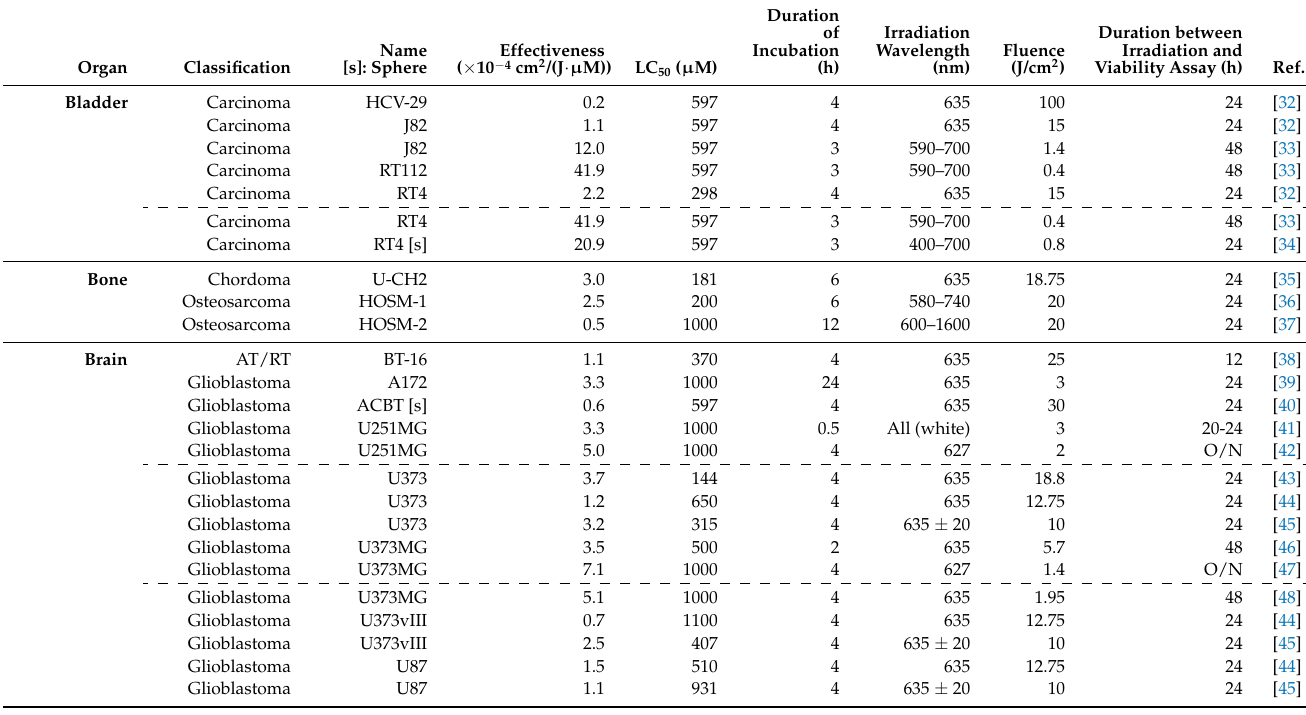
Table 1. In vitro 5-Aminolevulinic acid photodynamic therapy (5-ALA PDT) experiments for human cancer cell lines.